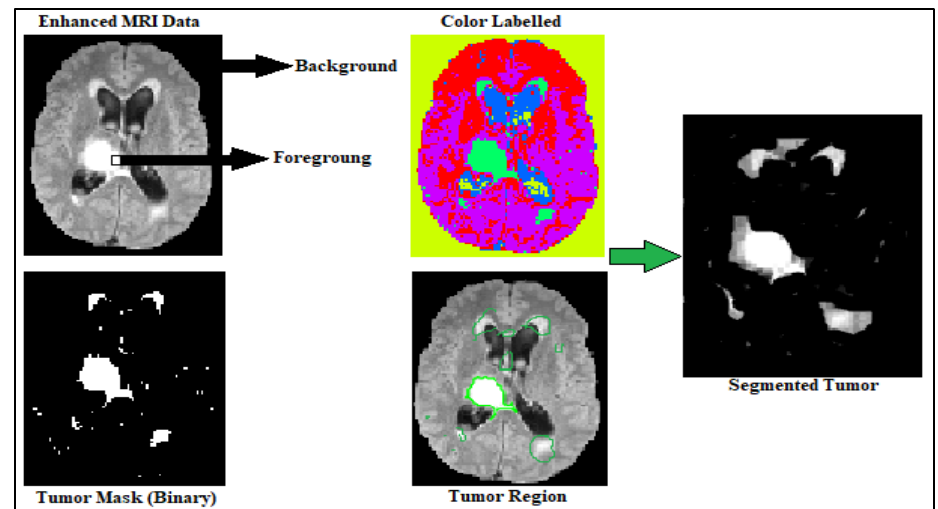
Figure 4. Segmentation using K-means